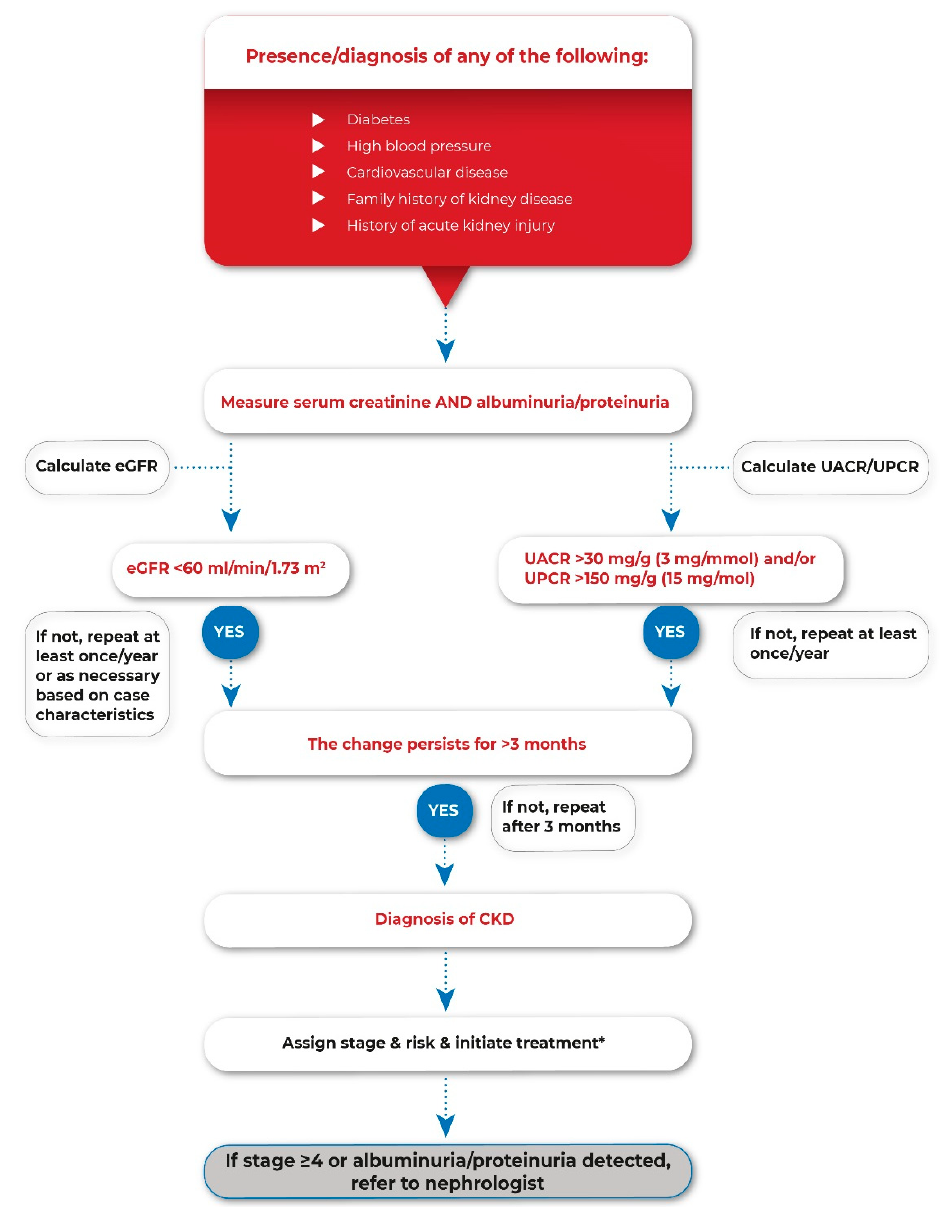
Figure 1. Screening algorithm of CKD in high-risk population. CKD, chronic kidney disease; eGFR, estimated glomerular filtration rate; UACR, urinary albumin-creatinine ratio; UPCR, urinary protein-creatinine ratio. * according to locally available protocols and guidelines.